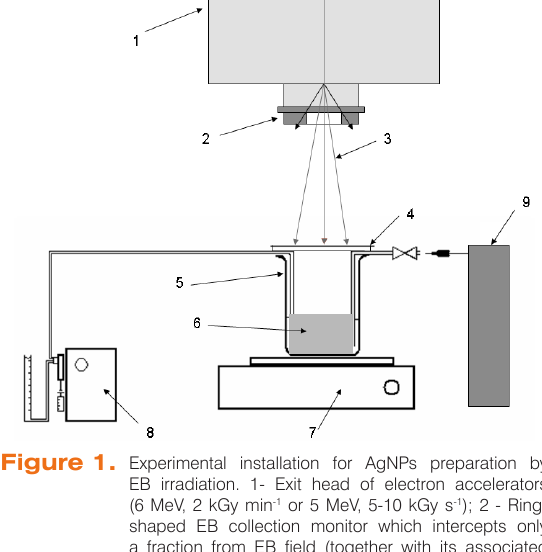
Figure 1. Experimental installation for AgNPs preparation by EB irradiation. 1- Exit head of electron accelerators (6 MeV, 2 kGy min -1 or 5 MeV, 5-10 kGy s -1 ); 2 - Ring- shaped EB collection monitor which intercepts